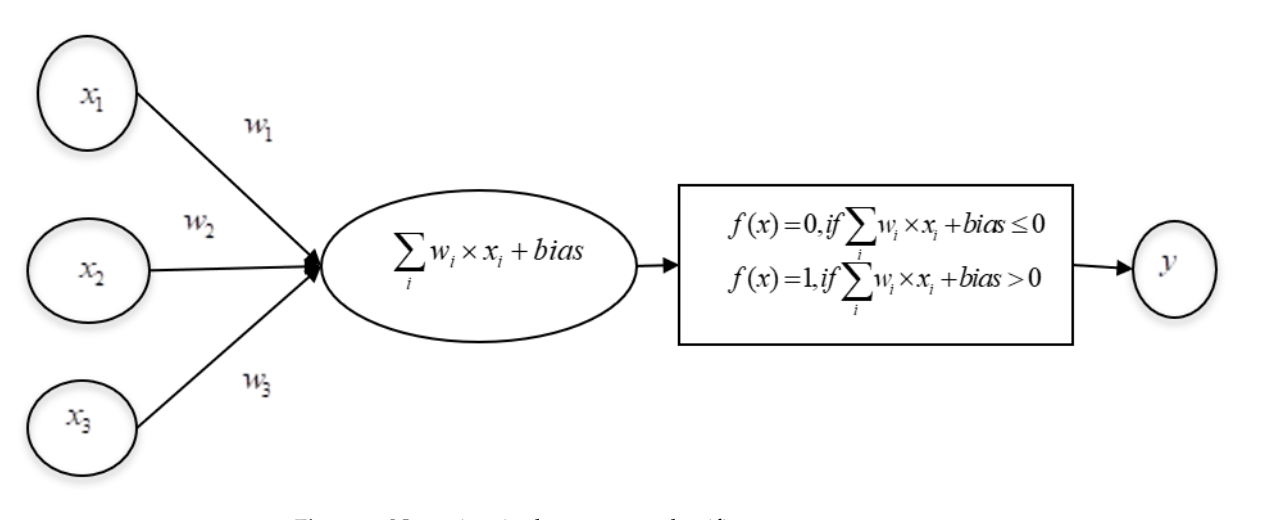
Figure 3. Neuro inspired perceptron classifier.